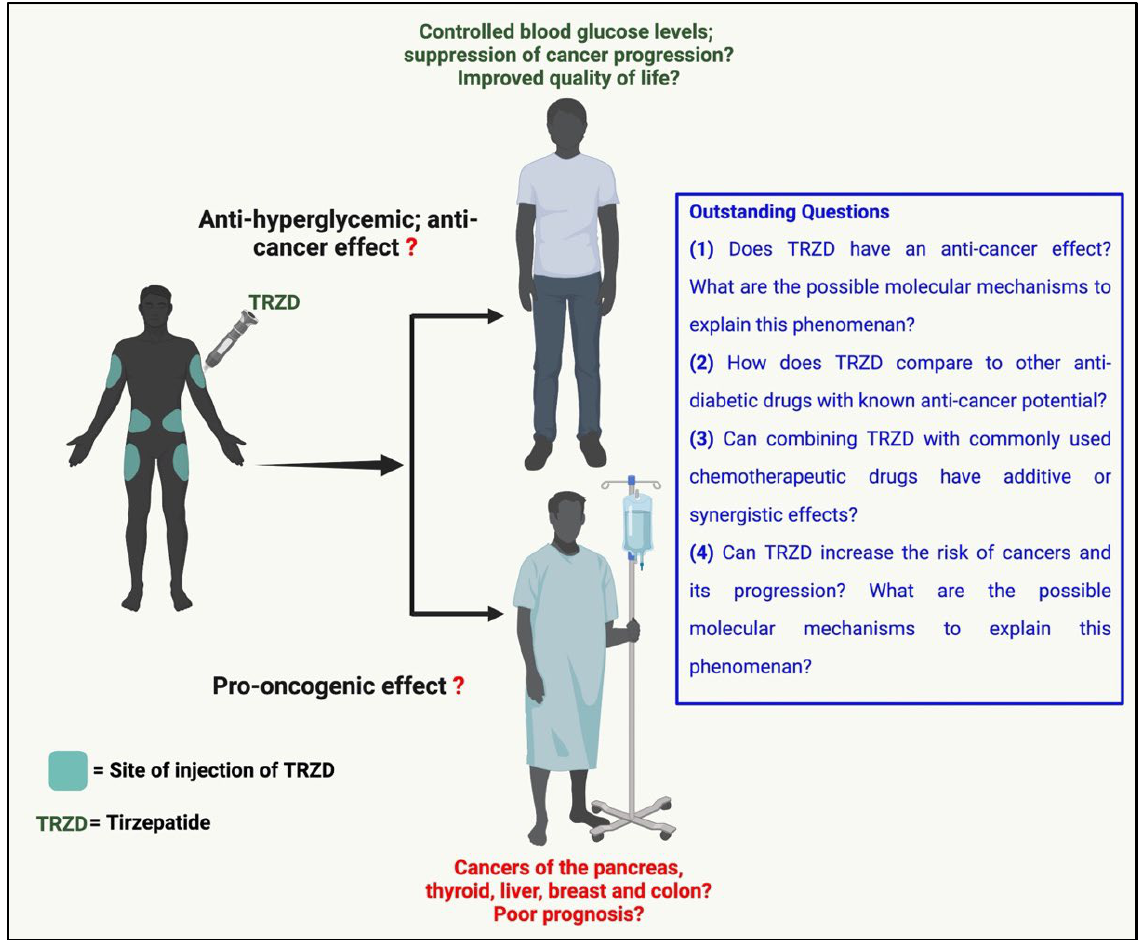
Figure 4. Outstanding questions regarding the use of tirzepatide (TRZD) in diabetic/obese or diabetic-/obese-cancer patients. Created with Biorender.com (accessed on 15 September 2022).